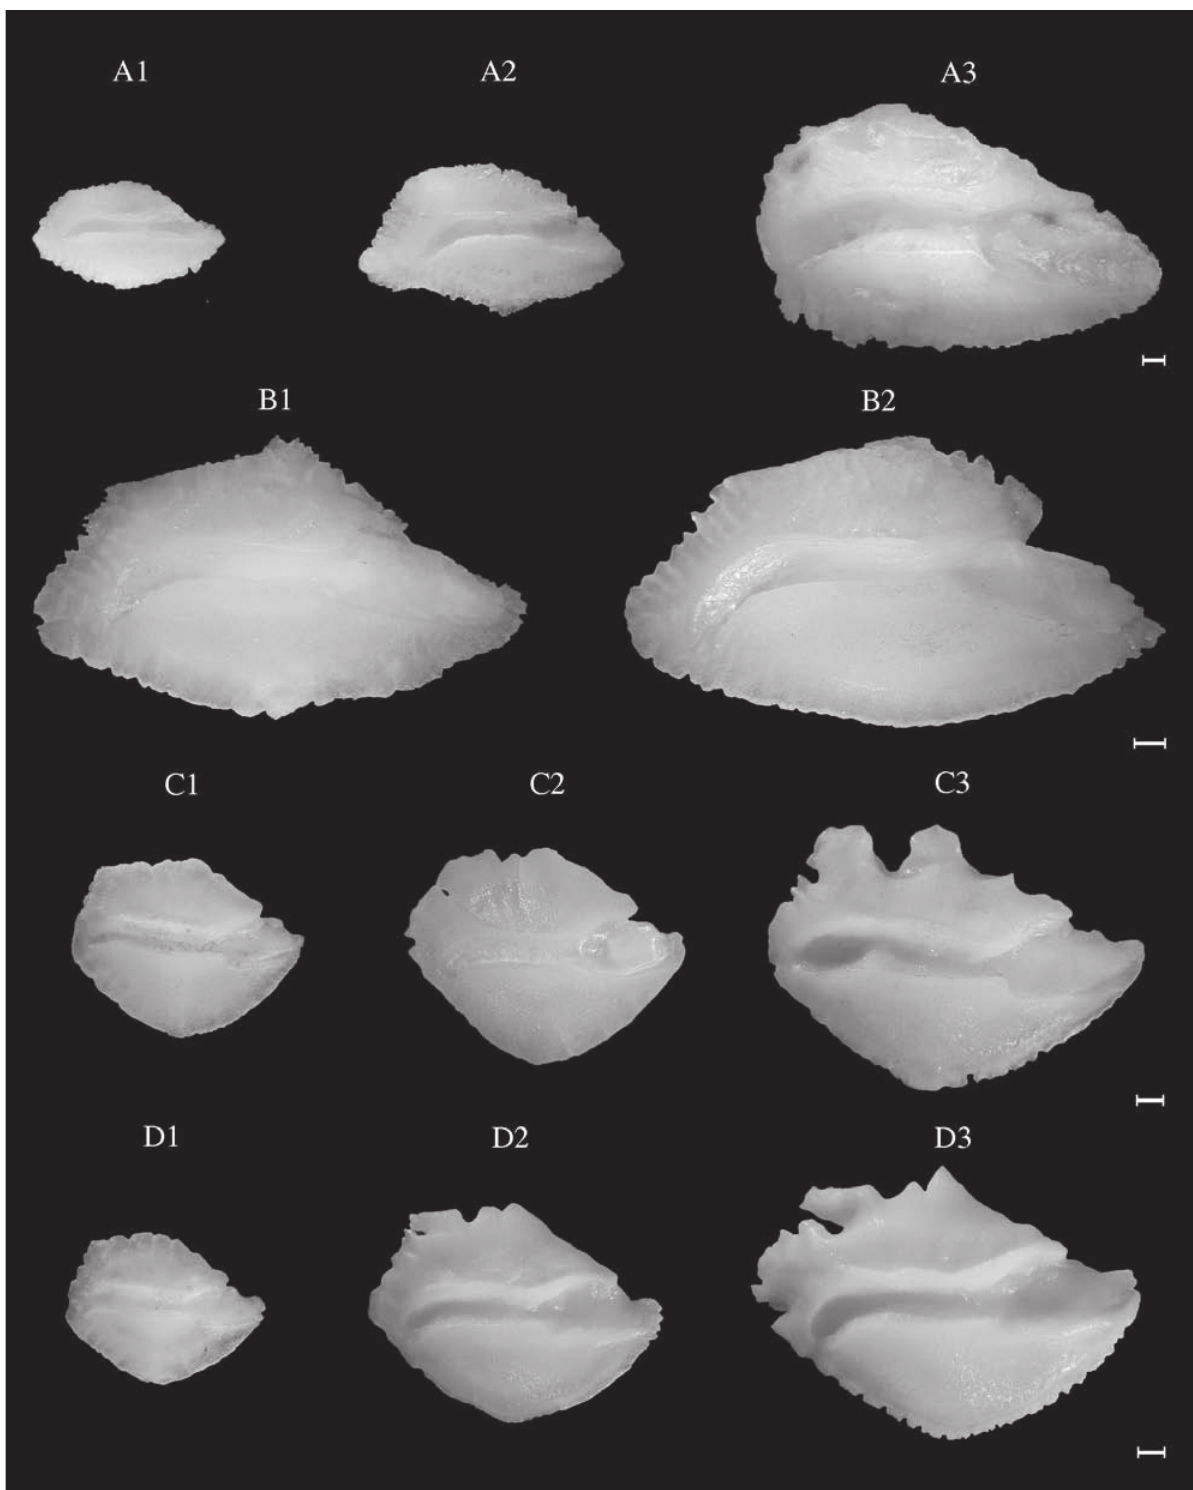
Fig. 57. – Dentex dentex (WM). TL: A1, 22.5 cm; A2, 36.5 cm; A3, 81.0 cm. Dentex gibbosus (CEA). TL: B1, 47.8 cm; B2, 52.0 cm. Dentex macrophthalmus . TL: C1, 13.4 cm (CEA); C2, 24.1 cm (NEA); C3, 30.0 cm (CEA). Dentex maroccanus (CEA). TL: D1, 14.9 cm; D2, 23.1 cm; D3, 28.5 cm. Scale bar = 1